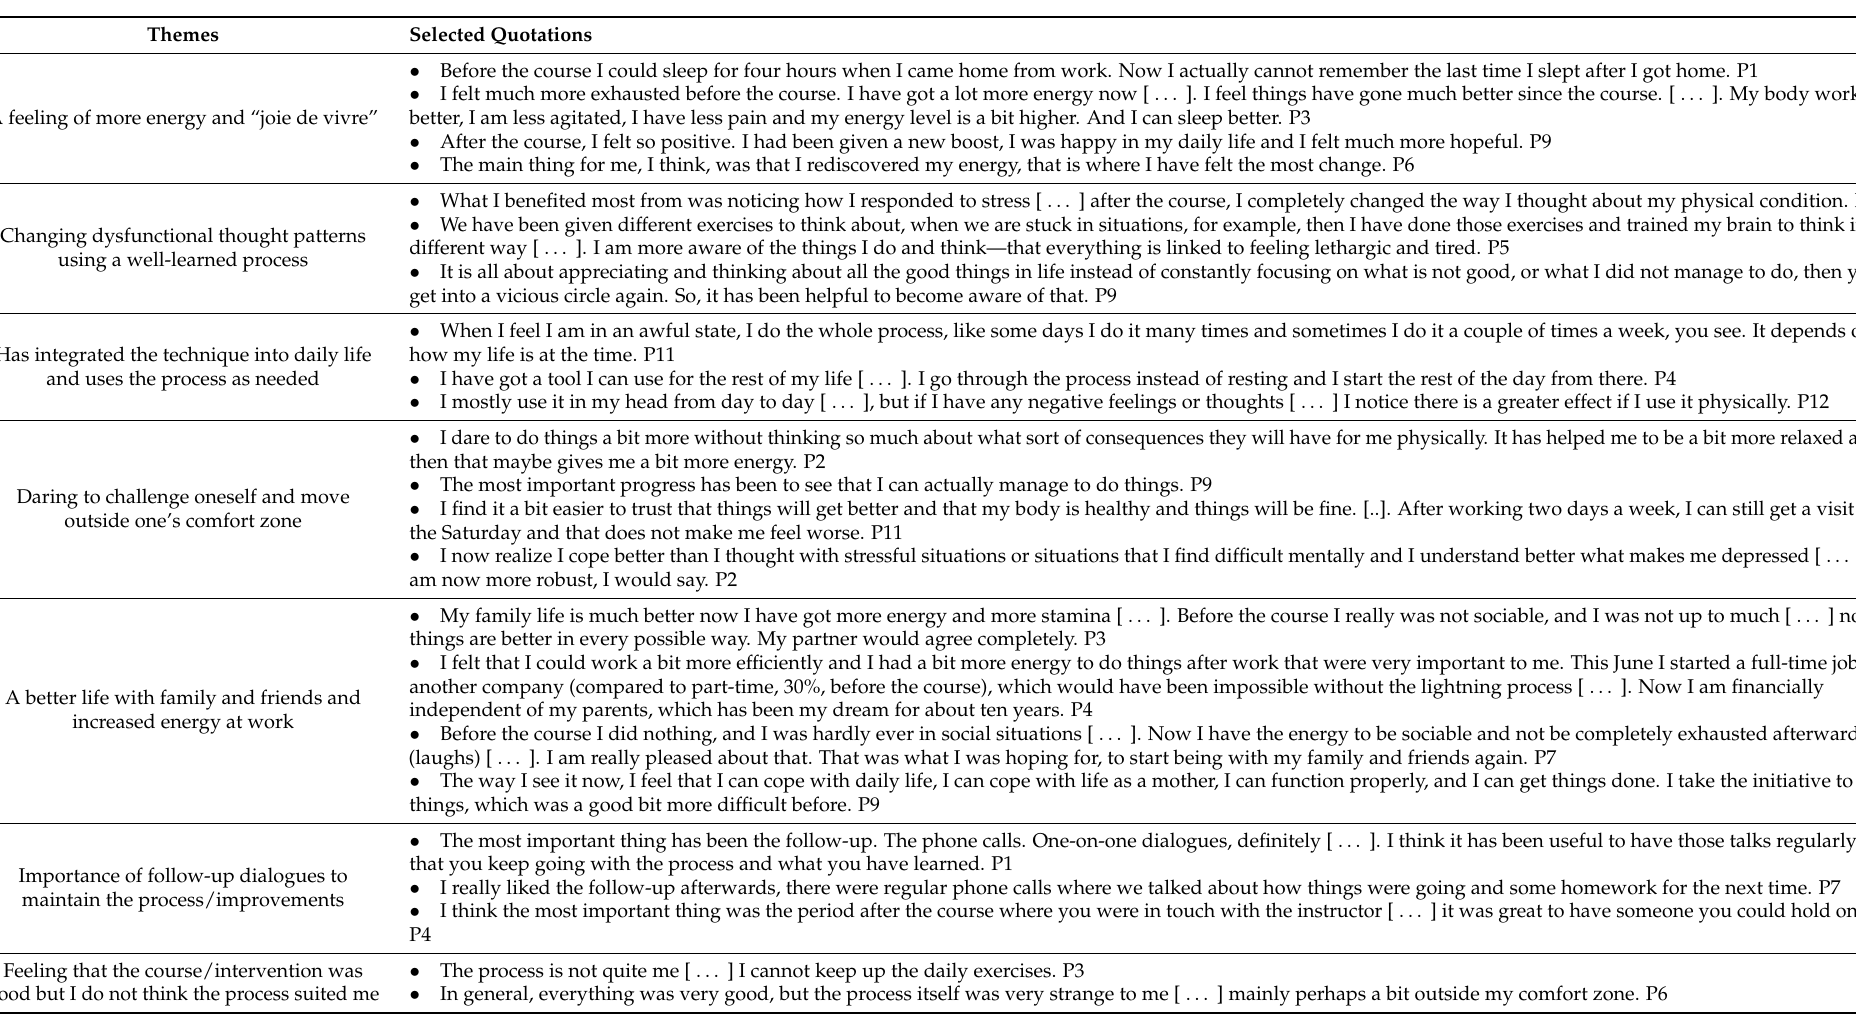
Table 3. Selected quotations from the interviews reported by the 11